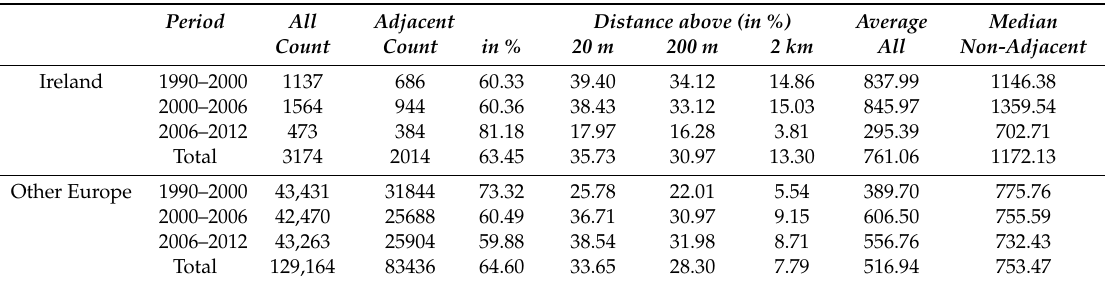
Table 5. Distance of new artificial areas to existing artificial structures for Ireland and Other Europe for 1990–2012.